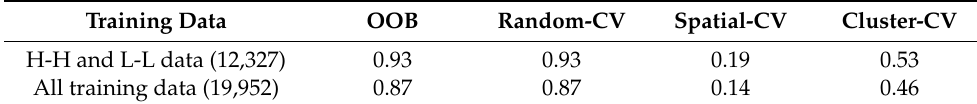
Table 3. QRF performance (R 2 ) for the three different CV schemes. The internal RF OBB error assessment is also provided.